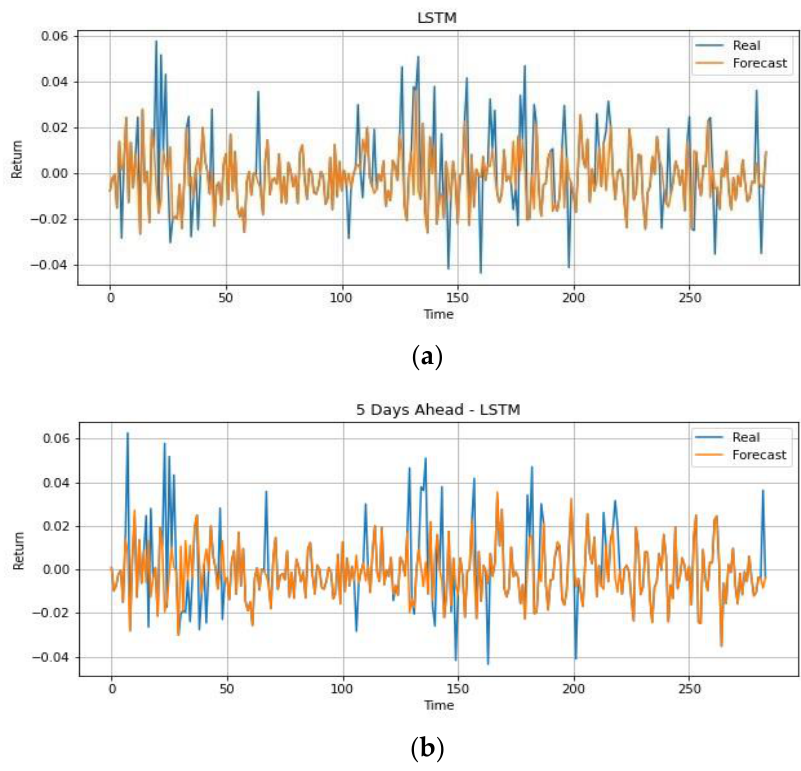
Figure 10. LSTM Forecasting Result for One-Day- ( a ) and Five-Day-Ahead ( b ).